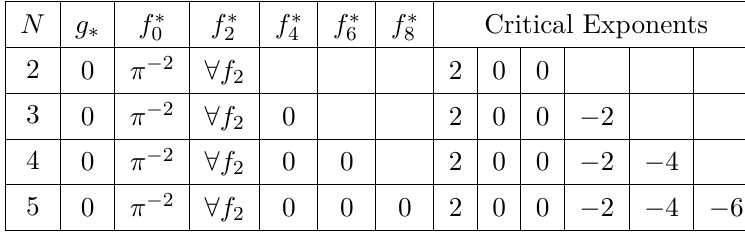
Table 1 . GFP line in D = 2 .